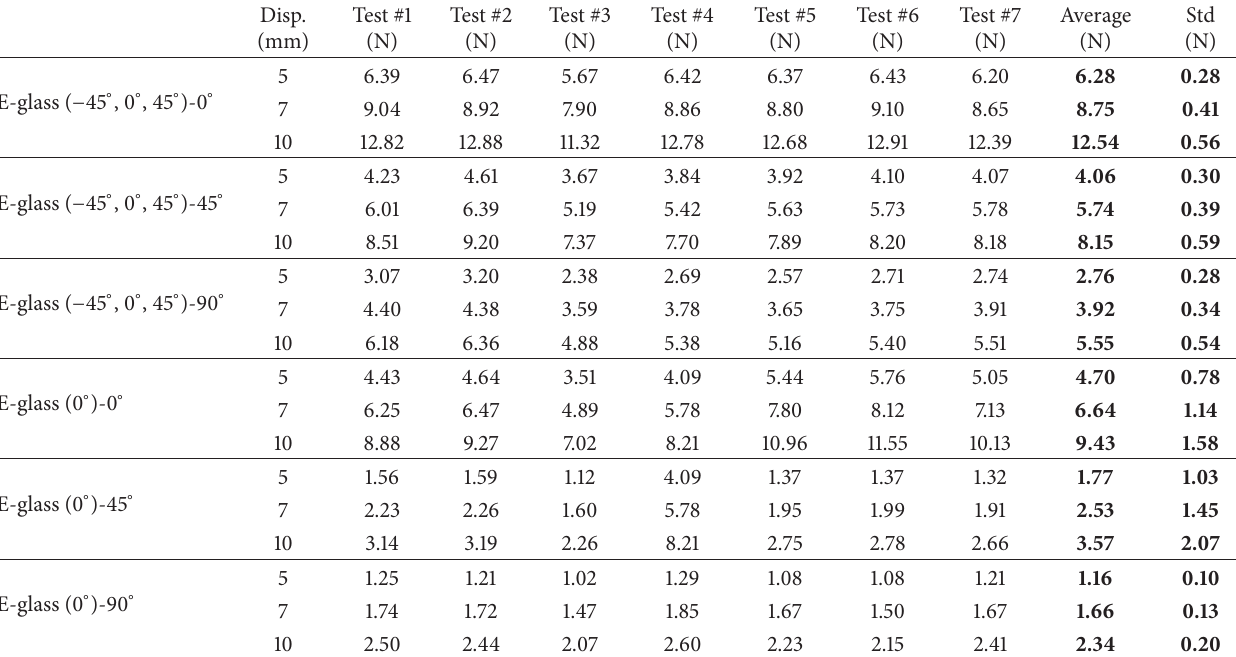
Table 2: Forces versus displacements of the fiberglass composite strips made by the E-glass (0 ∘ ) and E-glass ( − 45 ∘ , 0 ∘ , 45 ∘ ) with three different cutting directions (0 ∘ , 45 ∘ , 90 ∘